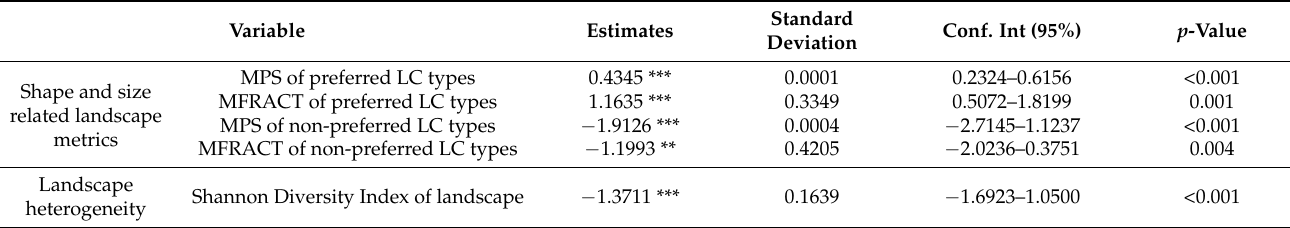
Table 3. Summary table for landscape metrics, which shows the GLM results after multimodel averaging of best candidate models showing relative importance of each explanatory variable on Skylark abundance, estimated parameter values ± Standard